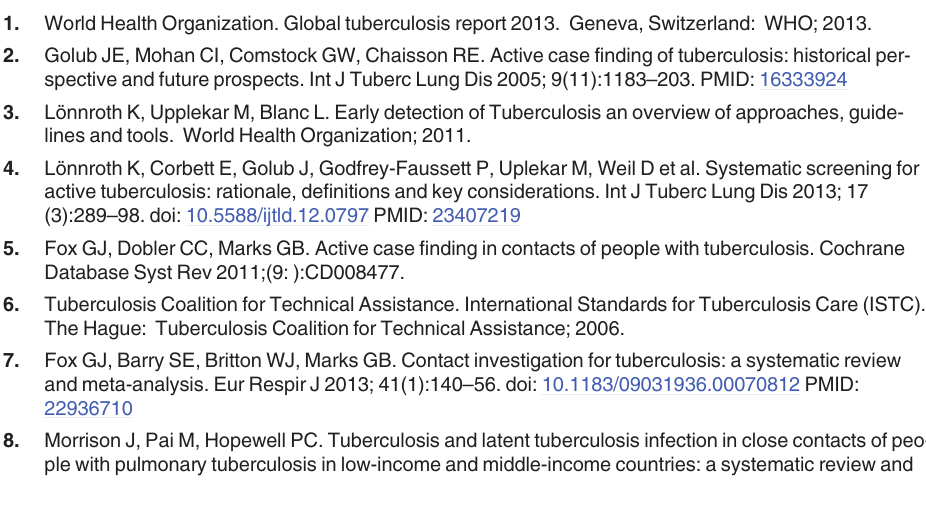
S1 Table. Overview screening data. S2 Table. Sensitivity analysis by exclusion of five biggest